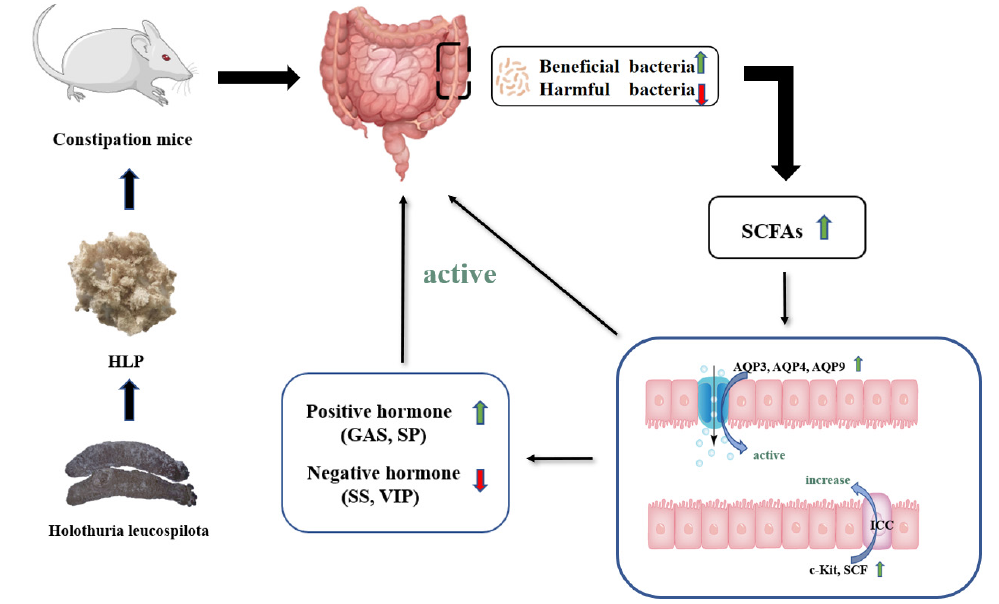
Figure 7. Potential mechanism of HLP relieving constipation in mice.